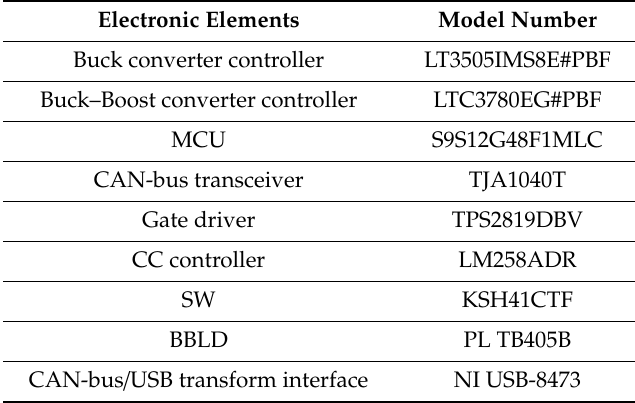
Table 4. Employed electronic elements on